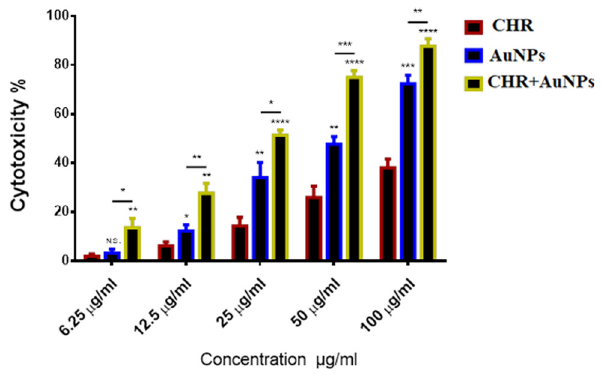
Figure 8: Cytotoxic e ff ects: CHR, AuNPs, and CHR – AuNPs on AMJ13 cell lines; n = 3,N.S.,non - signi fi cant, *P < 0.05,** P < 0.01,and*** P <